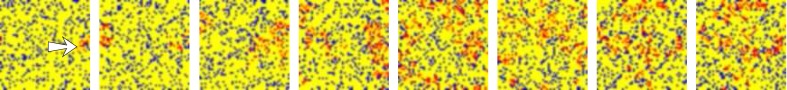
Snapshots of an activity movie belonging to the network depicted in top panel of Figure 2. The figure illustrates the spatio-temporal patterns generated by the network in response to stimulus. Sequences develop in time from left to right with a time interval between frames of 50 a.u. Color code is the same used in Figure 3. The arrow in the first frame indicates the approximate location of the stimulated unit.